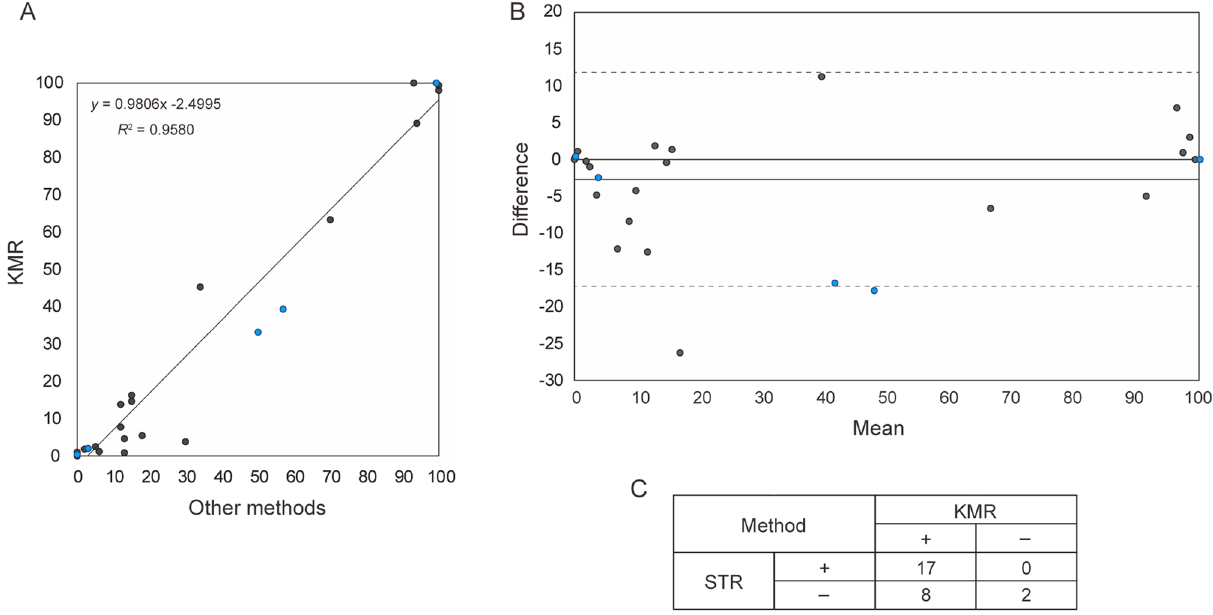
Figure 4. Recipient chimerism determined by KMR and conventional methods. ( A ) Correlation between recipient chimerism evaluated with KMRtrack and those with STR-PCR or in-house SNP-qPCR. Values of recipient chimerism are shown as percentages in each sample. ( B ) Bland–Altman analysis to compare percentage estimates of chimerism by KMR versus STR-PCR/in-house SNP-qPCR. Dotted lines indicate mean ± 2 SD (standard deviation). ( C ) Positivity/negativity of recipient chimerism determined by KMRtrack (KMR) and STR-PCR (STR). ( A, B ) Black dots indicate the values measured by KMRtrack and STR-PCR, while blue dots were values from KMRtrack and in-house